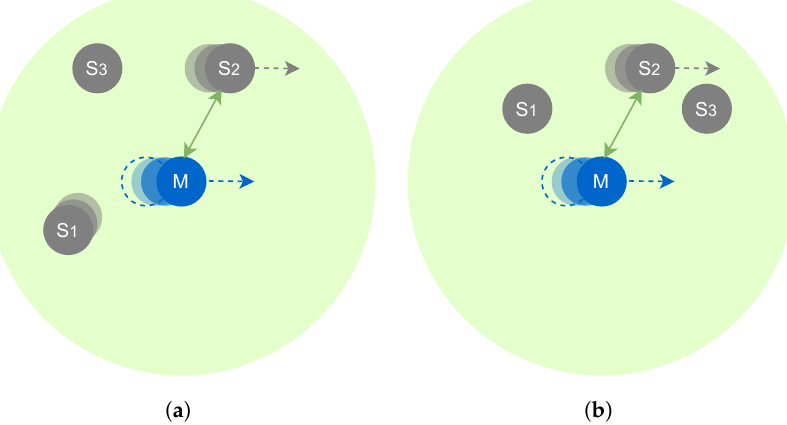
Figure 9. Two examples of ARMOR algorithm, ( a ) when mobile node M wisely selects S2 as its parent since it provides the most long-lasting connection. RPL would have chosen S1 by only considering the short-term link quality, and ( b ) depicts a scenario, where ARMOR is less effective as M ignores the stable (fixed) parents ( S1, S3 ) and sticks to S2